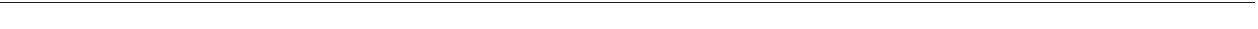
Fig. 5 The rescue of F-actin stress fi bers by CAPZB KD in HC is YAP/TAZ-dependent. a Representative confocal images of MCF10A cells exposed to control, CAPZB or YAP + TAZ (Y/T_p1) siRNA oligos. MCF10A cells were immunostained for endogenous YAP/TAZ and F-actin. Scale bars are 10 µ m. b Representative LC3-II western-blots of MCF10A cells exposed to either vehicle (DMSO) or blebbistatin treatment. MCF10A cells were transfected with the corresponding siRNAs and plated at low and high con fl uencies. Bars represent the mean ± s.d. ( n = 3; *** P < 0.001, ** P < 0.01, * P < 0.05; two-tailed one sample t -test). c Representative images of LC3 and ATG9A double immunostaining in MCF10A cells plates at LC and HC con fl uencies. MCF10A cells were exposed to CAPZB and/or YAP/TAZ (Y/T_p1) siRNAs and plated at low and high con fl uencies. Scale bar is 10 µ m. d Quanti fi cation of ATG9A – LC3 colocalization in MCF10A cells plated and treated as in ( c ). The Pearson ’ s correlation and Manders ’ overlap (the amount of LC3 in the ATG9A compartment) coef fi cients were used to measure the colocalization of LC3 with ATG9A in more than 30 and 100 cells in LC and HC conditions, respectively (*** P < 0.001; two-tailed t -test). e Representative LC3-II western-blots of low con fl uency MCF10A cells exposed to CAPZB and/or YAP/TAZ (Y/T_p1) siRNAs. n = number of independent biological replicates unless otherwise